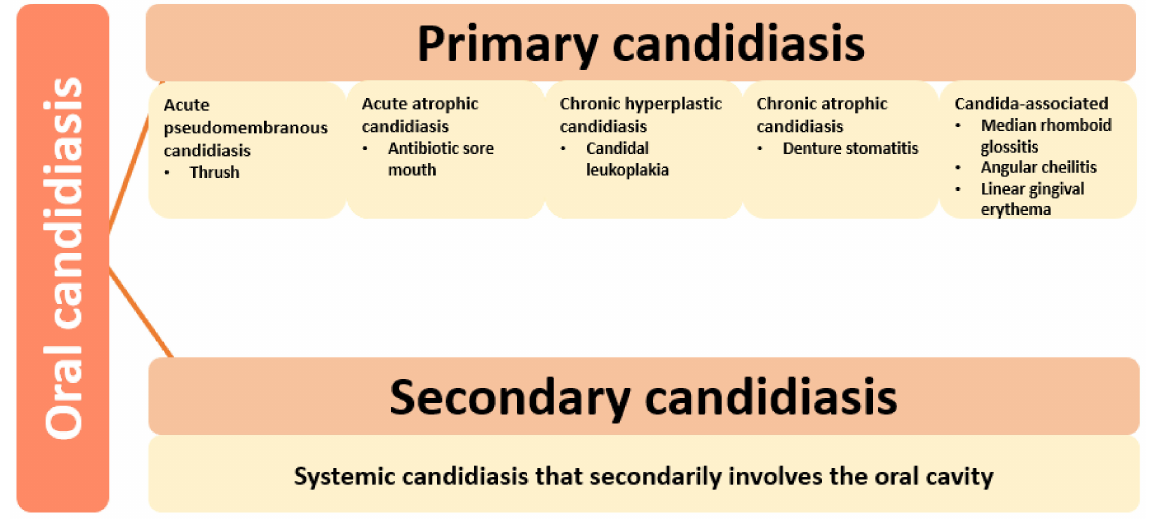
Figure 3. Types of oral candidiasis. Created based on information from literature references